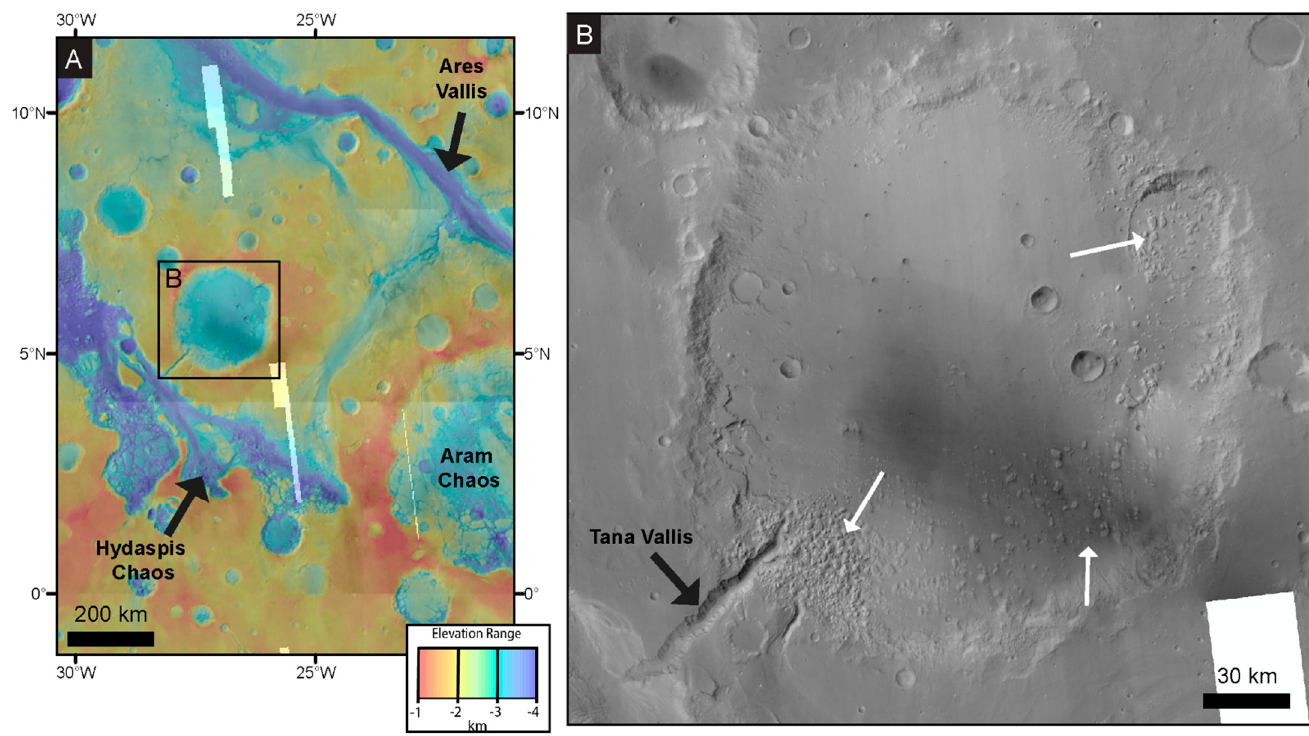
Figure 1. Galilaei crater and its surroundings. ( A ) A colorized elevation map of Galilaei crater (boxed) and the surrounding area. Elevation data are blended MOLA and HRSC at 60% transparency with underlying CTX image mosaic basemap (see Data and Methods). ( B ) Galilaei crater shown in visual image (CTX) mosaic. The crater was a paleolake that drained through the Tana Vallis outflow channel (black arrow) and hosts interior blocks discussed as chaos terrain in this work (white arrows). North is up in all figures.